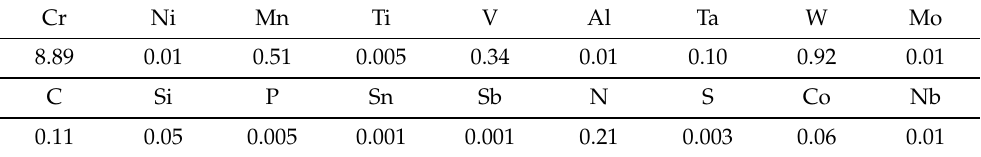
Table 1. Chemical composition (wt %) of the EUROFER-97 plate material (Fe balanced).